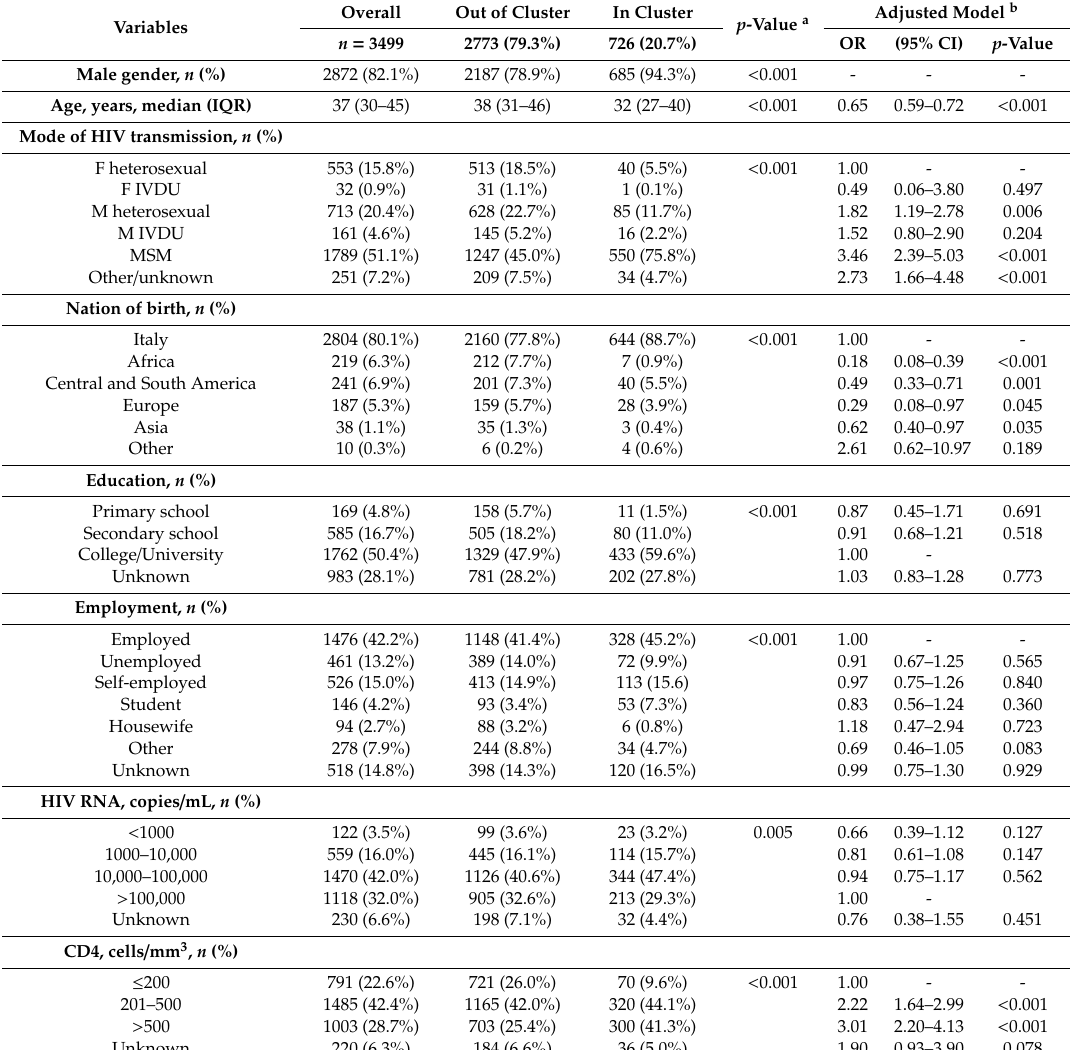
Table 1. Patient’s characteristics and factors associated with HIV-1 molecular transmission